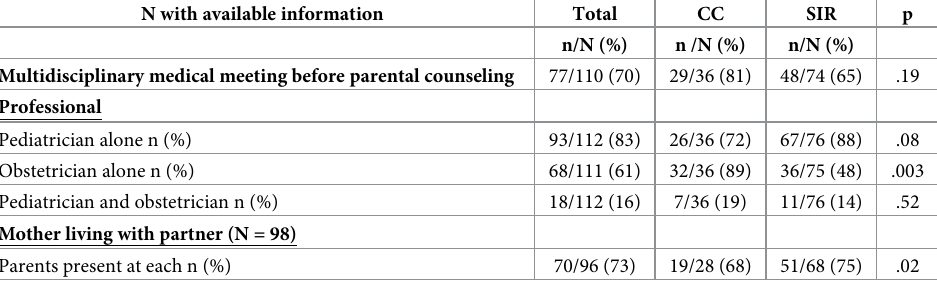
Table 4. Participants in predelivery counseling about delivery room management, reported by health-care professionals. N with available